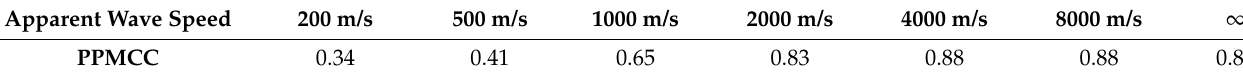
Table 11. Numerical value of PPMCC of bending moment and shear force.